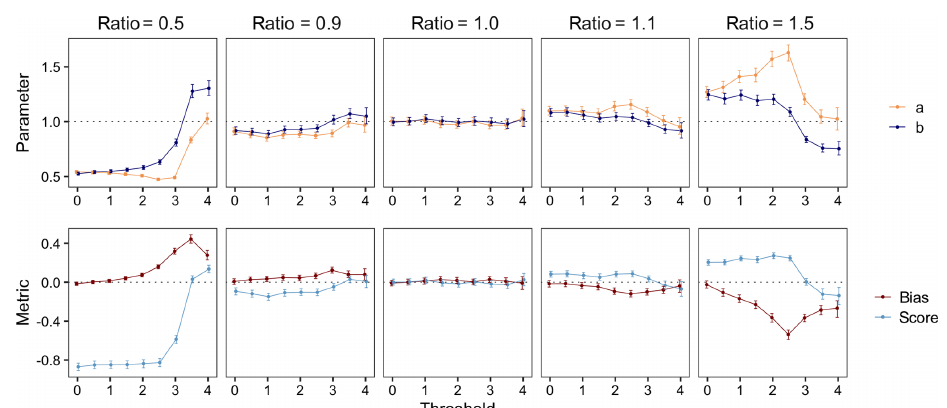
Figure 4. As Fig. 3 but with threshold τ = 2.